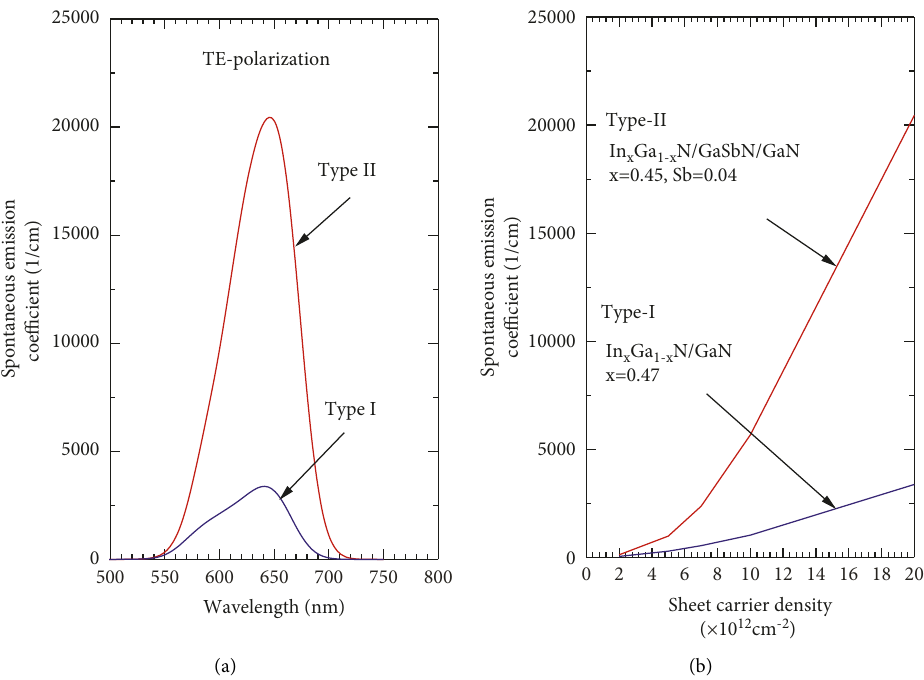
Figure 4: (a) TE-polarized spontaneous emission spectra and (b) peak intensities as a function of sheet carrier density for type-I In x Ga N/GaN and type-II In x Ga 1 − x N/GaN 1 − y Sb y /GaN ( x � 0 . 45, y � 0 . 04) QW 1 − x